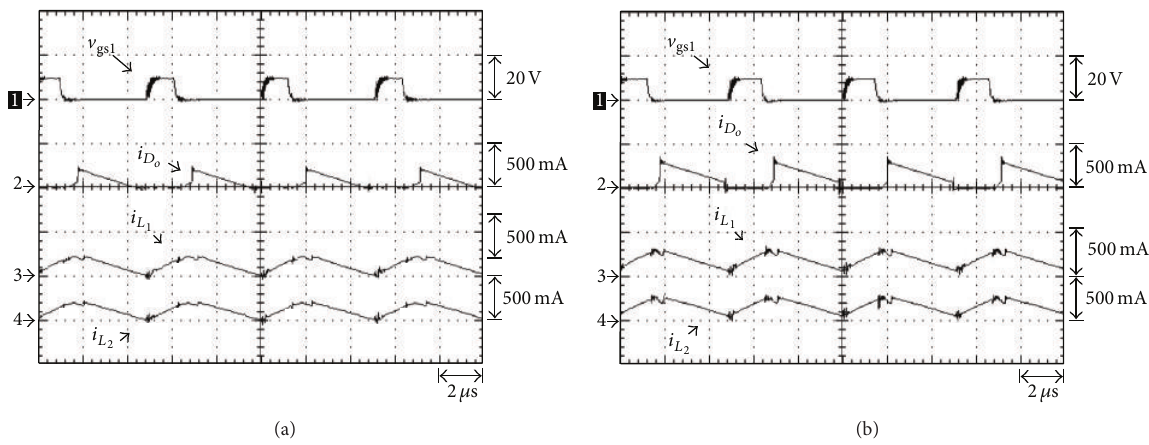
Figure 7: Measured waveforms: (a) 25% load—(1) V